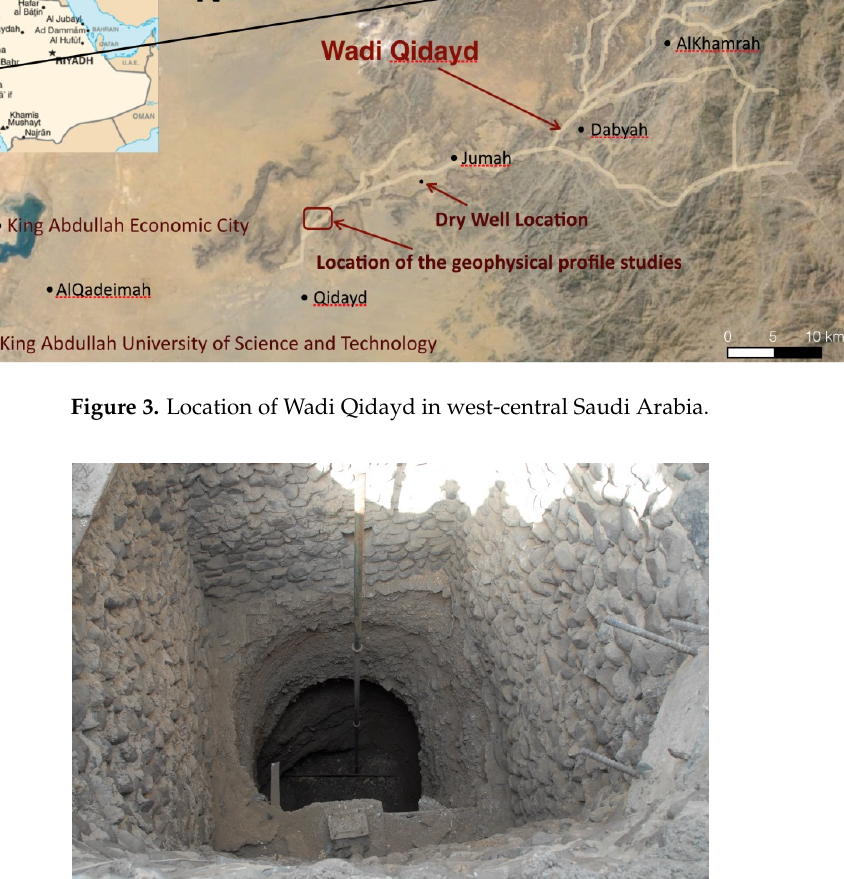
Figure 3. Location of Wadi Qidayd in west-central Saudi Arabia.